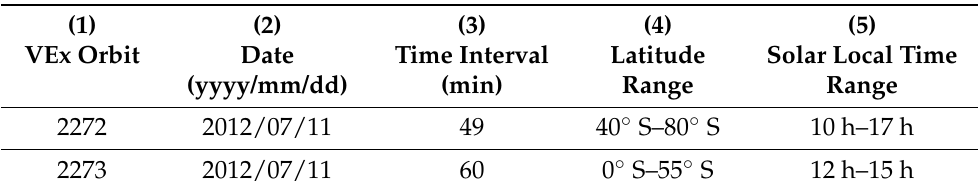
Table 2. ESA Venus Express/VIRTIS-M UV-visible channel at 380 nm observations circumstances: (1) orbit number; (2) UT date; (3) time interval between selected image pairs; (4–5) corresponding latitude and solar local time range. The imaging spatial resolution varies between 15 km per pixel for polar latitudes and about 45 km per pixel for equatorial